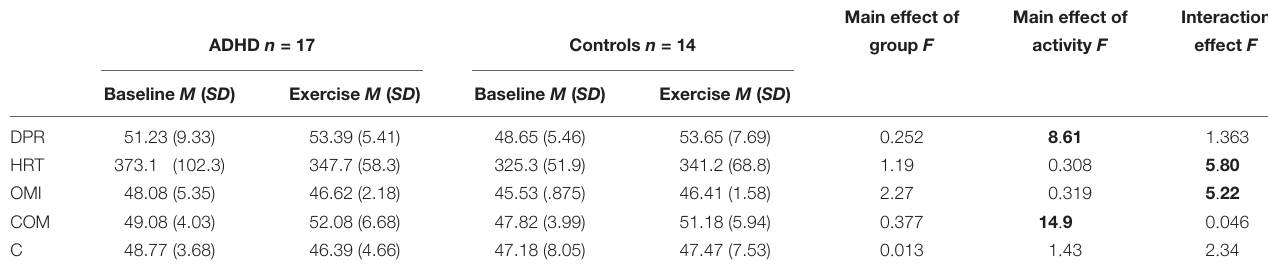
TABLE 1 | Performance data on measures of